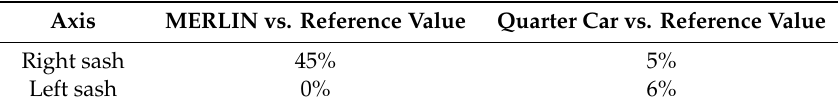
Table 5. % of error obtained according to proposed